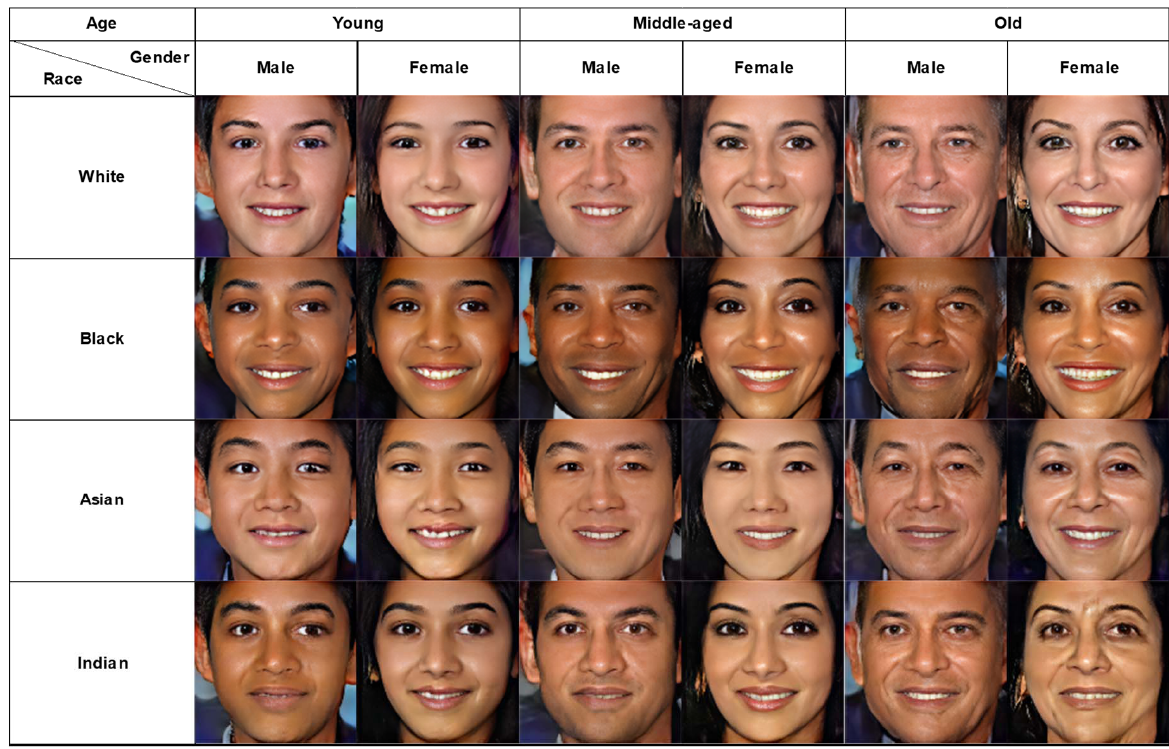
Figure 4. First set of results of our model: faces from an identical latent vector with 24 different group attributes.